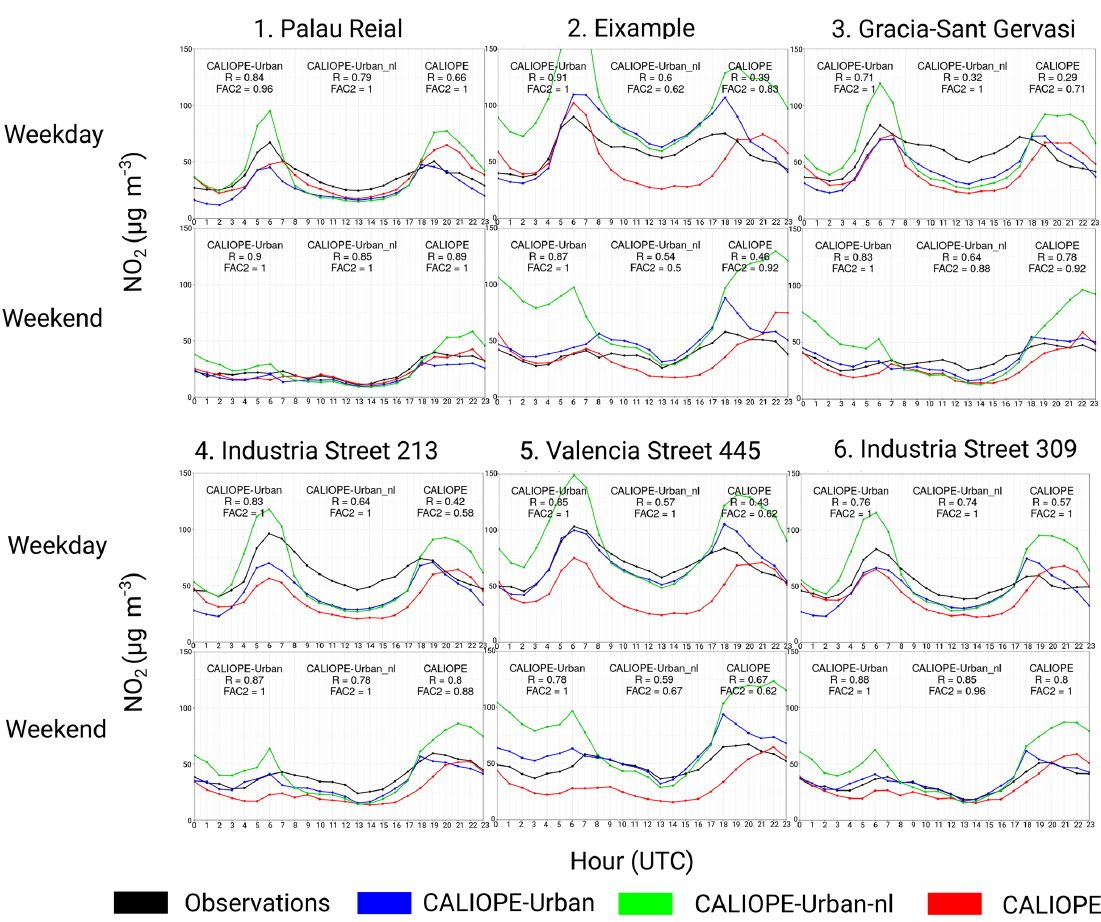
Figure 9. NO 2 average daily cycle at all sites described in Sect. 3.1 during April and May 2013 for weekday and weekend. Observations are represented as black coloured lines, red lines are CALIOPE, blue lines are CALIOPE-Urban and green lines represent CALIOPE-Urban without local developments